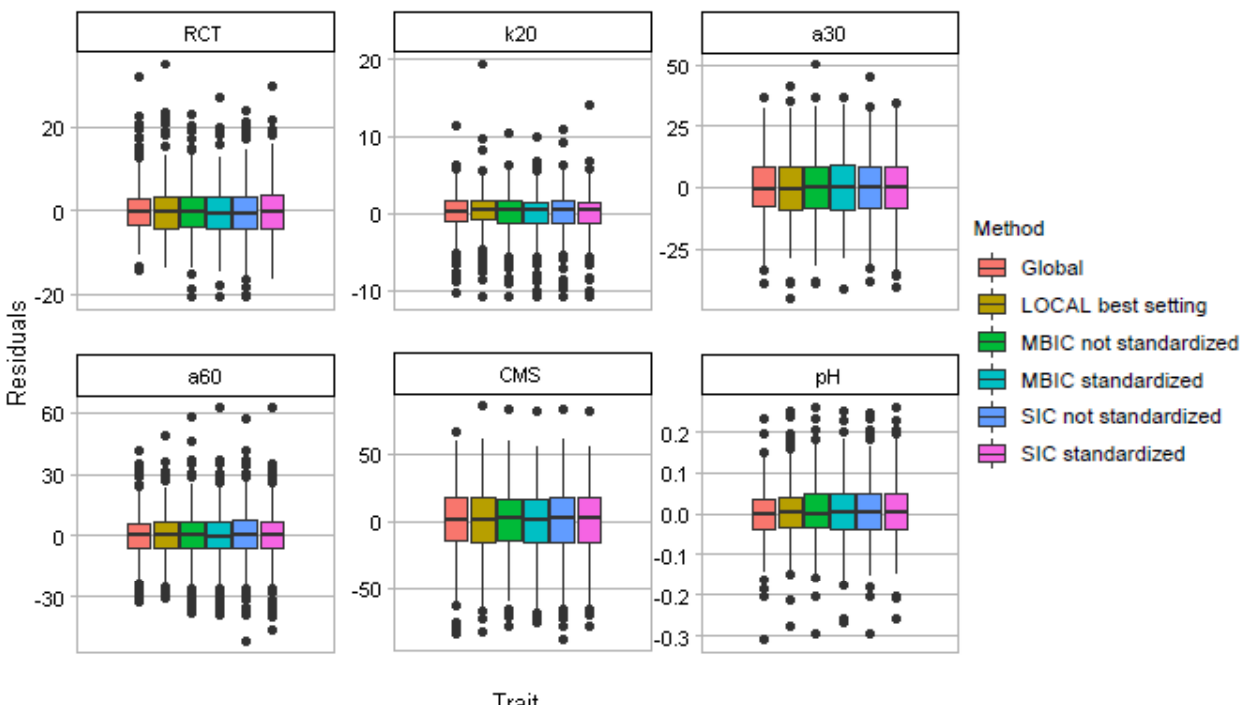
Figure 1. Boxplots of the residuals for each trait from global, LOCAL, and local changepoint approaches according to the alternative penalties tested on spectral data either standardised or unstandardised prior to neighbour selection.